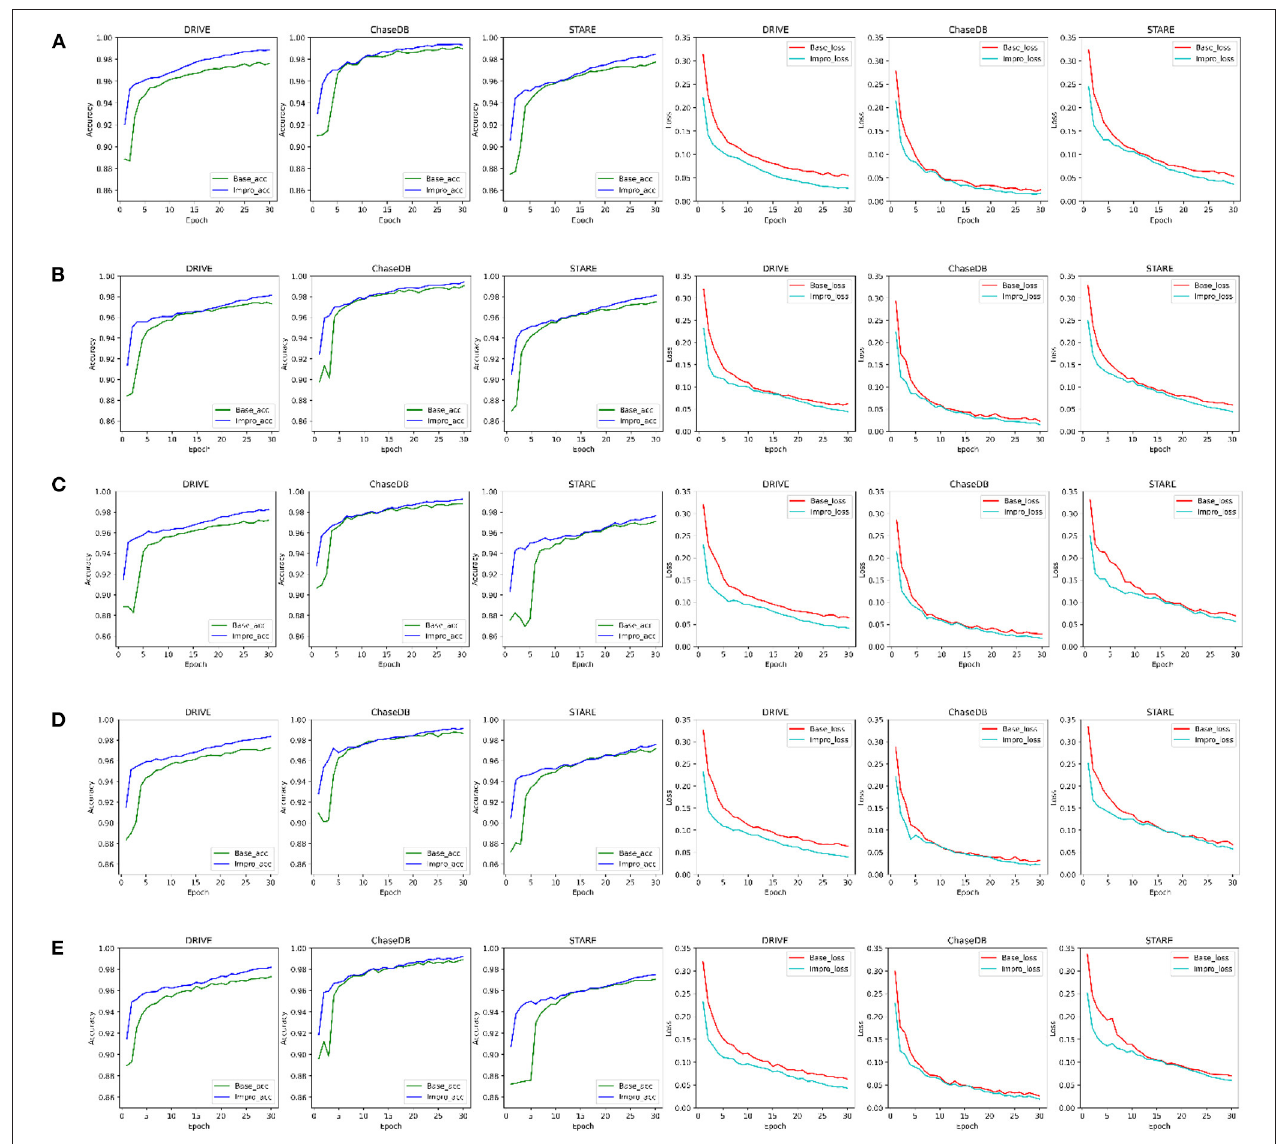
FIGURE 5 | Comparison of the baseline and upgraded models on training set: (A) 5-way 3-shot; (B) 4-way 3-shot; (C) 3-way 3-shot; (D) 3-way 4-shot; and (E) 3-way 5-shot.